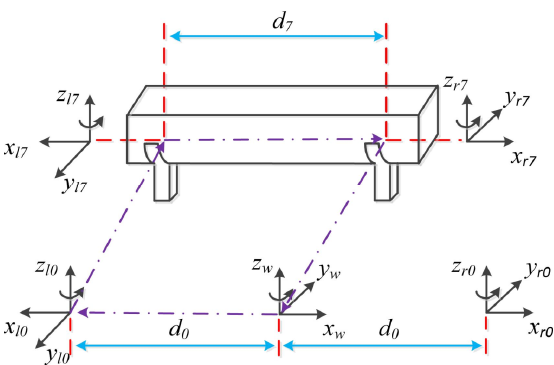
Figure 1. Closed-chain constraints for dual redundant manipulators.